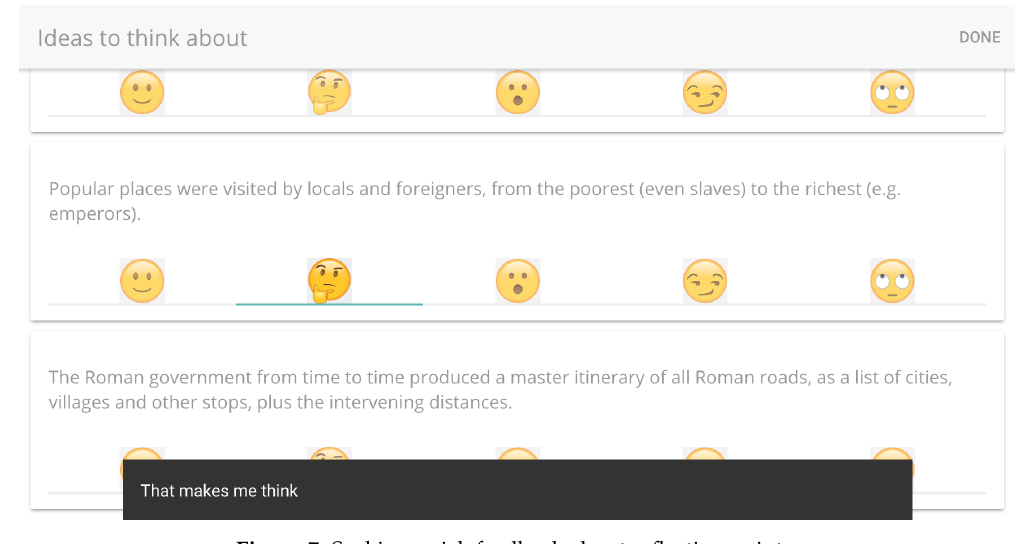
Figure 7. Seeking quick feedback about reflection points.